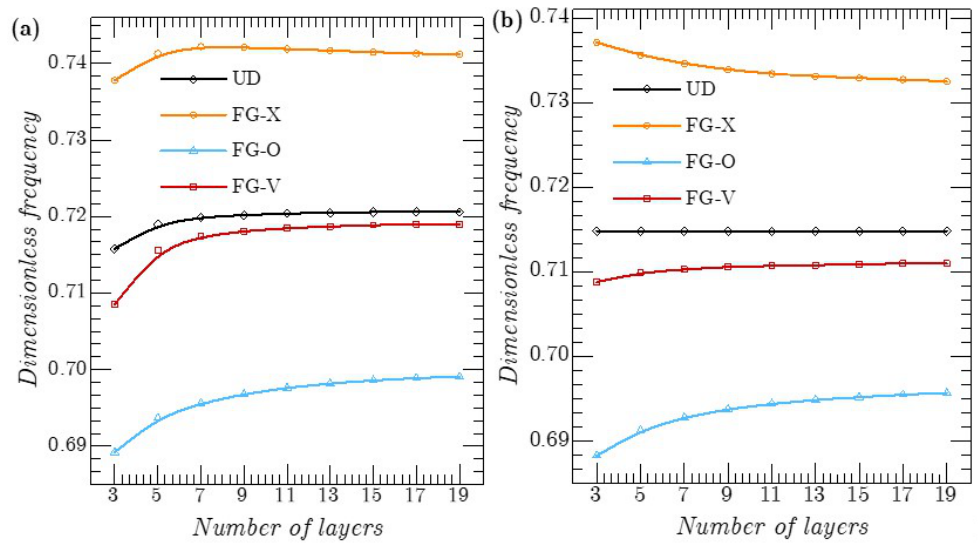
Figure 4. The effect of the number of layers “ N ”: ( a ) Cross-ply fibers ( b ) Unidirectional fibers (Plate, SSSS, b / a = 1, a / h = 10, V cnt = 0.01, V f max = 0.3, V f min